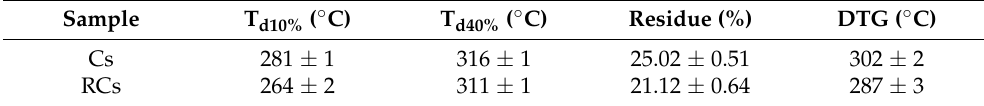
Figure 6. TGA and DTG (Inset) curves of Cs and RCs. Table 3. Representative thermal properties (TGA and DTG) values of Cs and RCs.